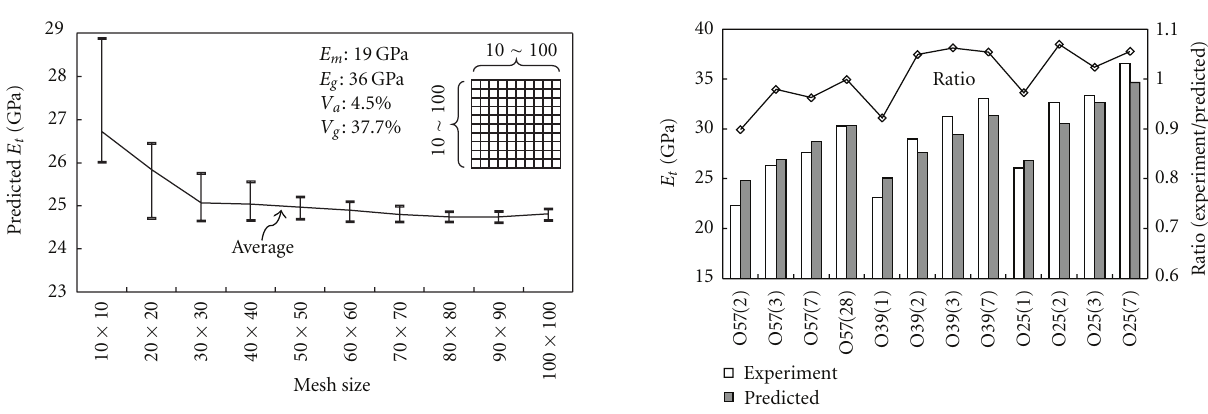
Figure 13: Tensile Young’s modulus predicted by employing grids of di ff erent fineness.